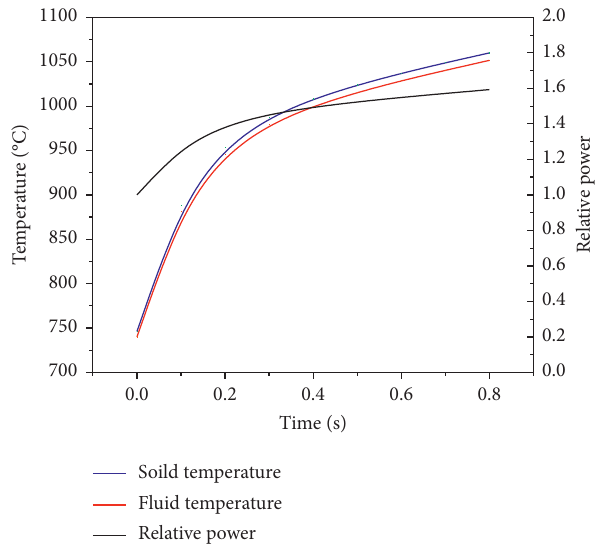
Figure 6: HTR-PM transient relative power and outlet temperature change in 0 . 8s. Table 8: Comparison among flux approximations in the precursor integral method for HTR-PM reactivity insertion in Δ t � 100ms. t ( s ) Δ t ( s ) Independent variables Δ t � 0.1 ms Zero-order Taylor expansion First-order Taylor expansion Exponential expansion